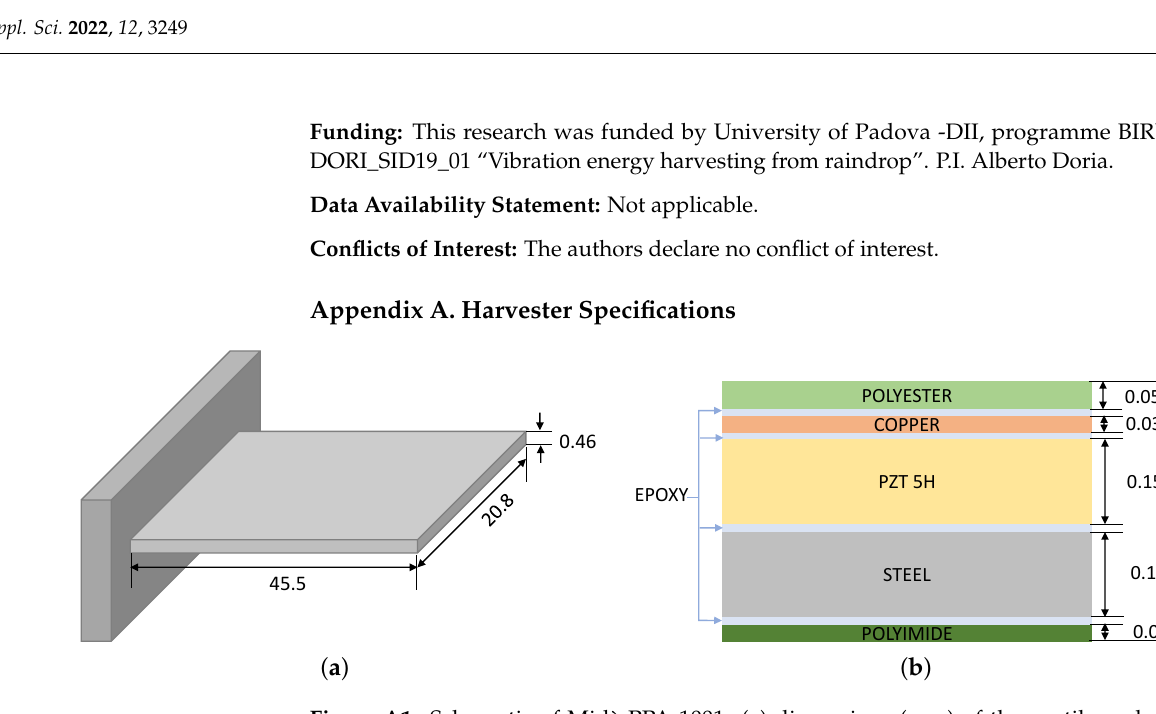
Figure A1. Schematic of Midè PPA-1001: ( a ) dimensions (mm) of the cantilever beam; ( b ) layer composition and thickness (mm). Table A1. Properties of the harvester [32].